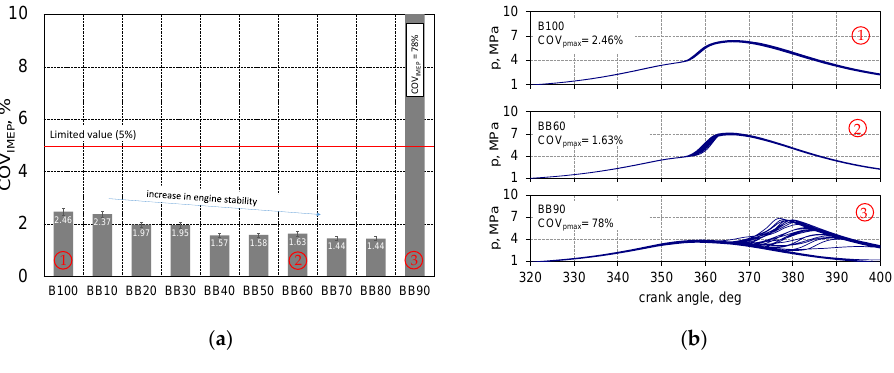
Figure 7. COV of IMEP ( a ) and cycle-by-cycle variation ( b ).